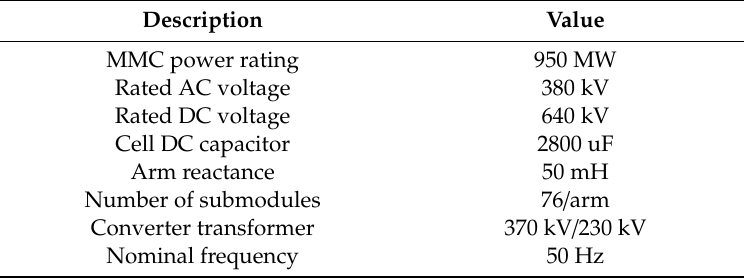
Table 2. Parameters of the simulated MMC HVDC system.